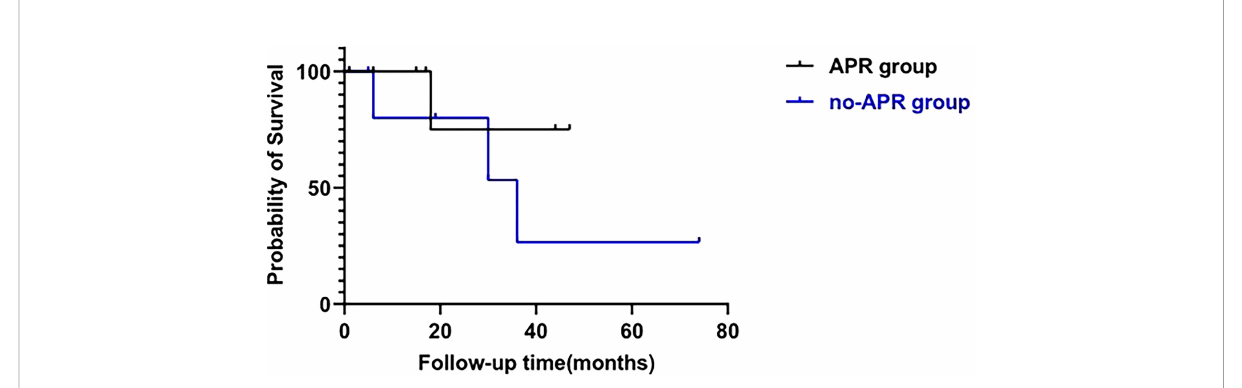
FIGURE 2 Survival analysis of patients treated with APR (APR group) and patients who did not receive APR (no-APR group). (log-rank test;